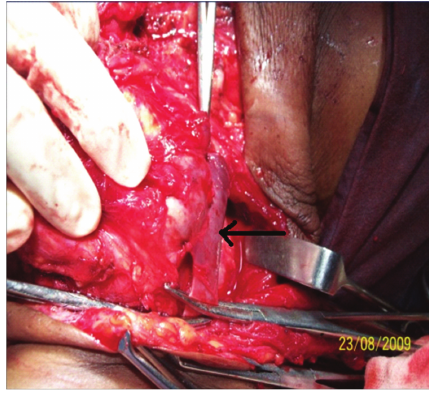
Figure 5: Cyst adherent to Internal jugular vein (arrow).